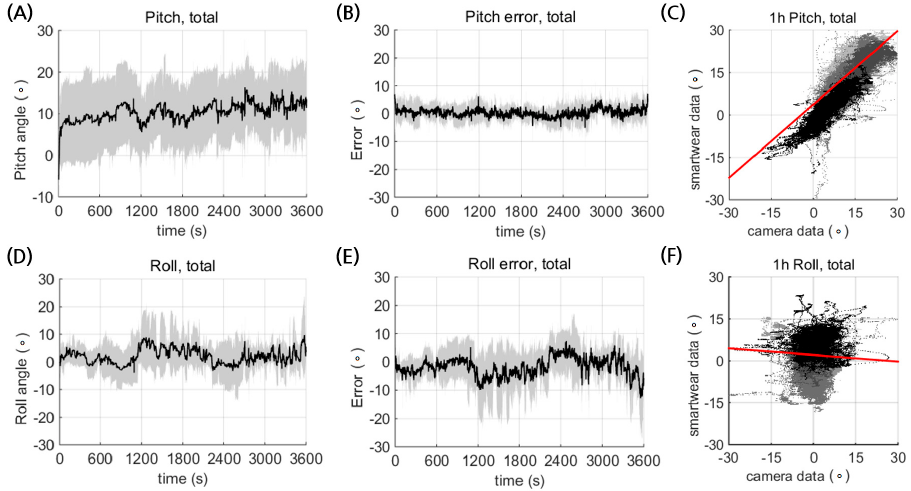
Figure 6. Postural estimation of pitch and roll from the smart wear during an hour of sitting activity. Average temporal trajectories of ( A ) pitch and ( D ) roll, and the corresponding temporal error profiles for ( B ) pitch and ( E ) roll. Mean values and standard deviation are shown as black solid lines and gray shading, respectively. Correlation between the estimated ( C ) pitch and ( F ) roll posture from the smart wear and the measurements from the camera. Different solid lines with different shades of gray indicate different subjects.